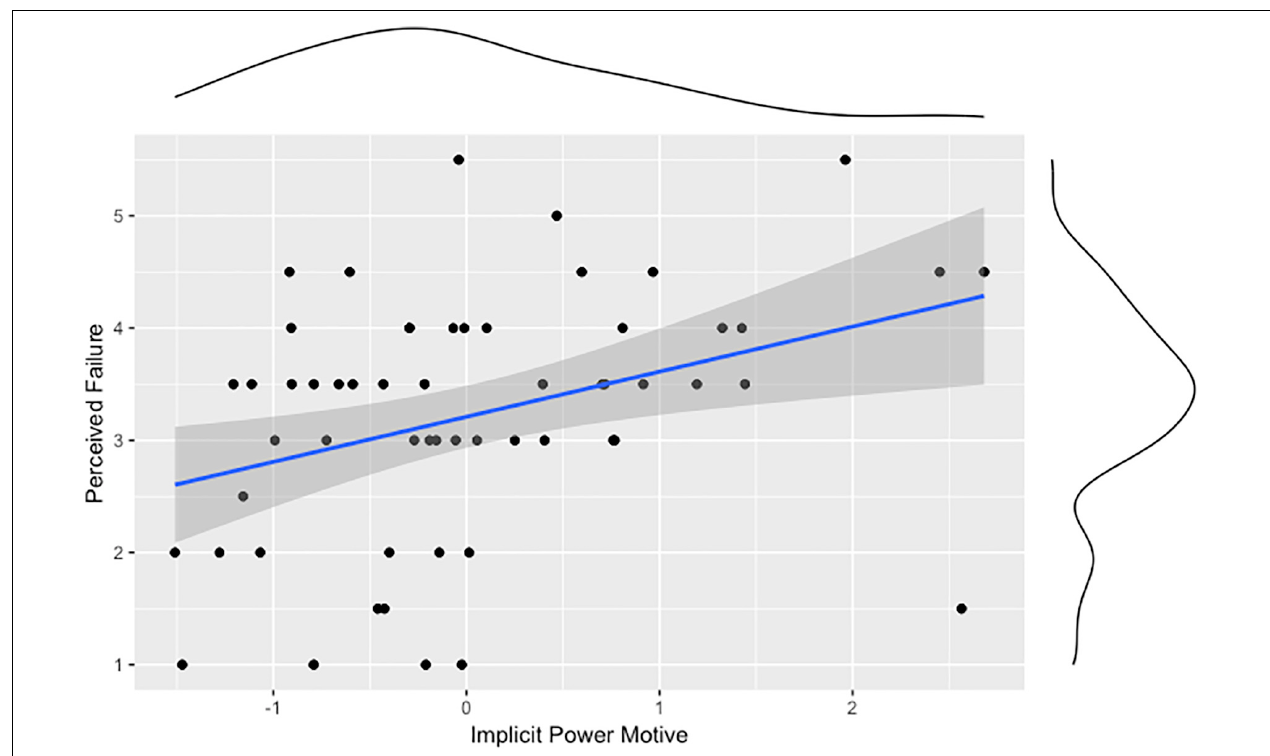
FIGURE 5 | Association between the implicit power motive and perceived